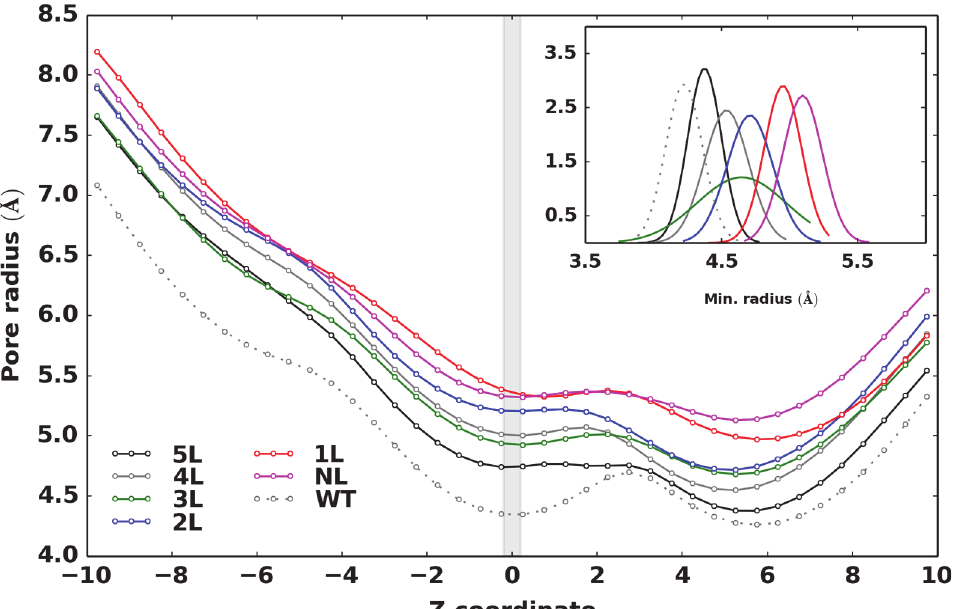
Fig 2. Average pore radius along the channel. Average pore radius along the channel axial position (Z-coordinate) with respect to the mutated site (shaded portion, Z = 0 Ang). Inset plot represents the distribution of minimum pore radius calculated by limiting the analysis to the constricted zone of the pore (residues 17 to